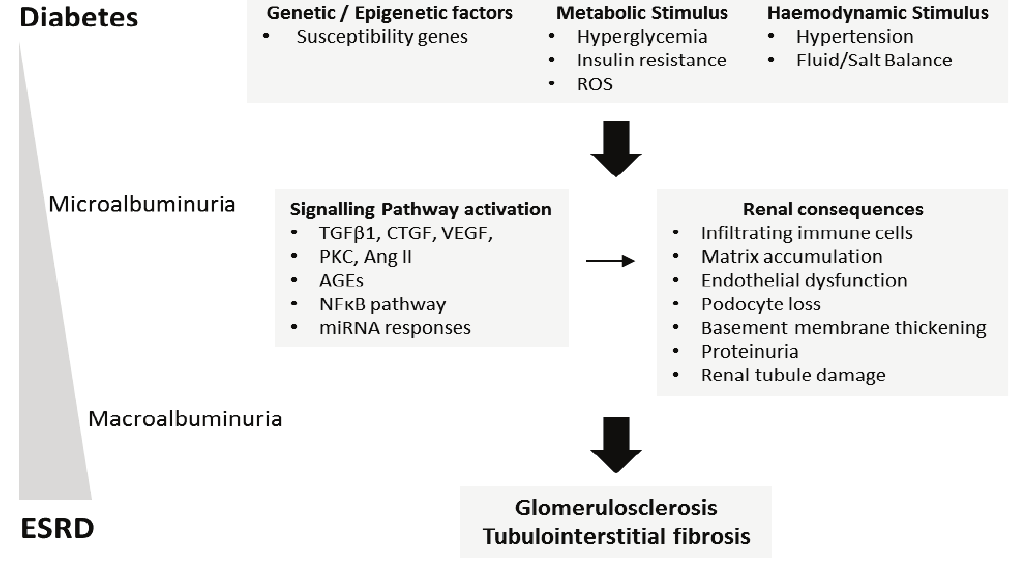
Figure 1. The pathophysiology of diabetic nephropathy. As a consequence of prolonged hyperglycaemia, diabetic nephropathy (DN) typically initiates as renal cellular hypertrophy and hyperfiltration, followed by progressive albuminuria and a decline in glomerular filtration rate (GFR). Microalbuminuria (urinary albumin excretion rate of 30 – 300 mg per day) develops 10 – 15 years after the onset of diabetes followed by macroalbuminuria (urinary albumin excretion rate of >300 mg per day) 15 – 25 years after diabetes onset. A combination of hyperglycaemia, inflammation, and hypertension drive the development and progression of DN. Presently, it is unclear why some diabetics are susceptible and others appear protected against the development of DN. Currently unknown causal and protective genetic variants have been suggested as one possible mechanism. At the cellular level, high glucose, Ang II, ROS, and profibrotic cytokines including TGF- β1 , VEGF and CTGF have been identified as important modulators driving renal fibrosis. More recently, miRNA-mediated regulation and histone modifications have also been implicated in DN pathogenesis. Mutations in one or more key signaling pathways implicated in DN may act to suppress or drive DN